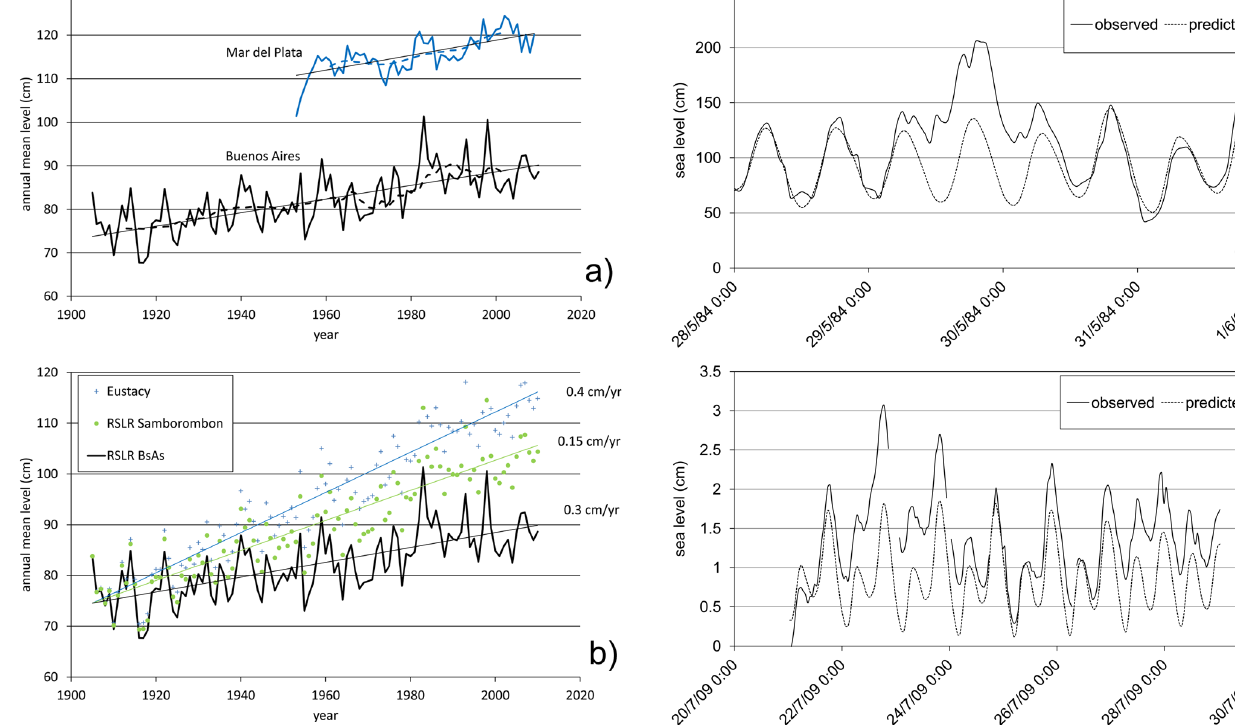
Fig. 7. An example of the difference between observed and the predicted tide levels during two extreme storm events recorded in Buenos